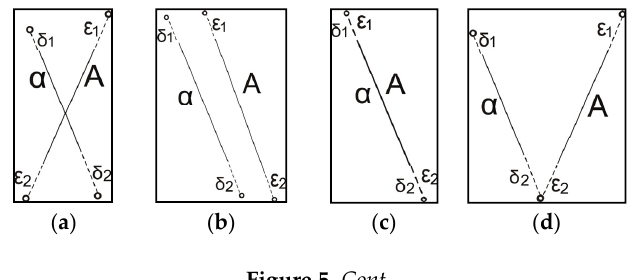
Table 1. Types of spatial relations between